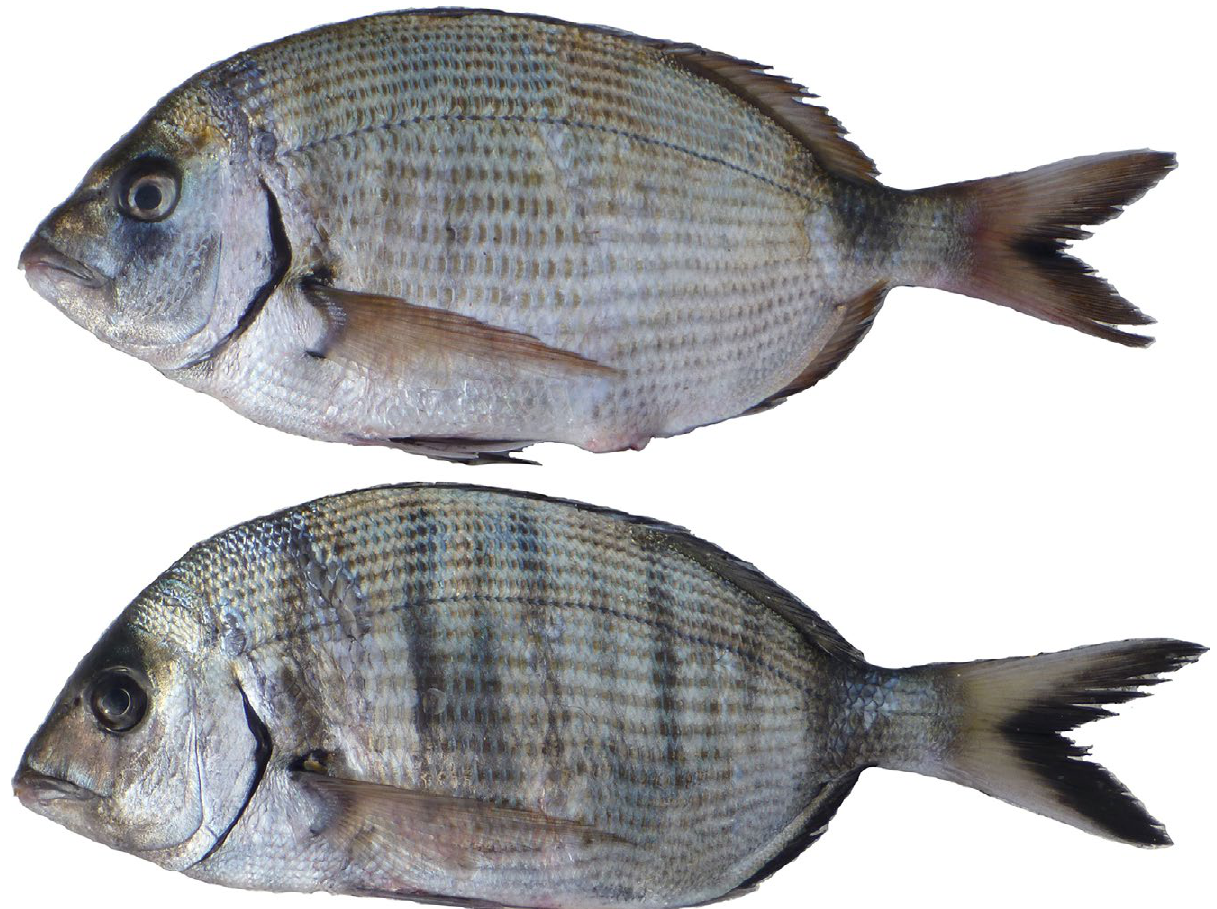
Fig. 8. – Diplodus sargus , HUJ 20542, 2 spec., 220-225 mm SL, France, Marseille, 8 Dec. 2015. Lateral view; photograph of the fresh coloura- tion taken a few hours after collection (Photograph: R.